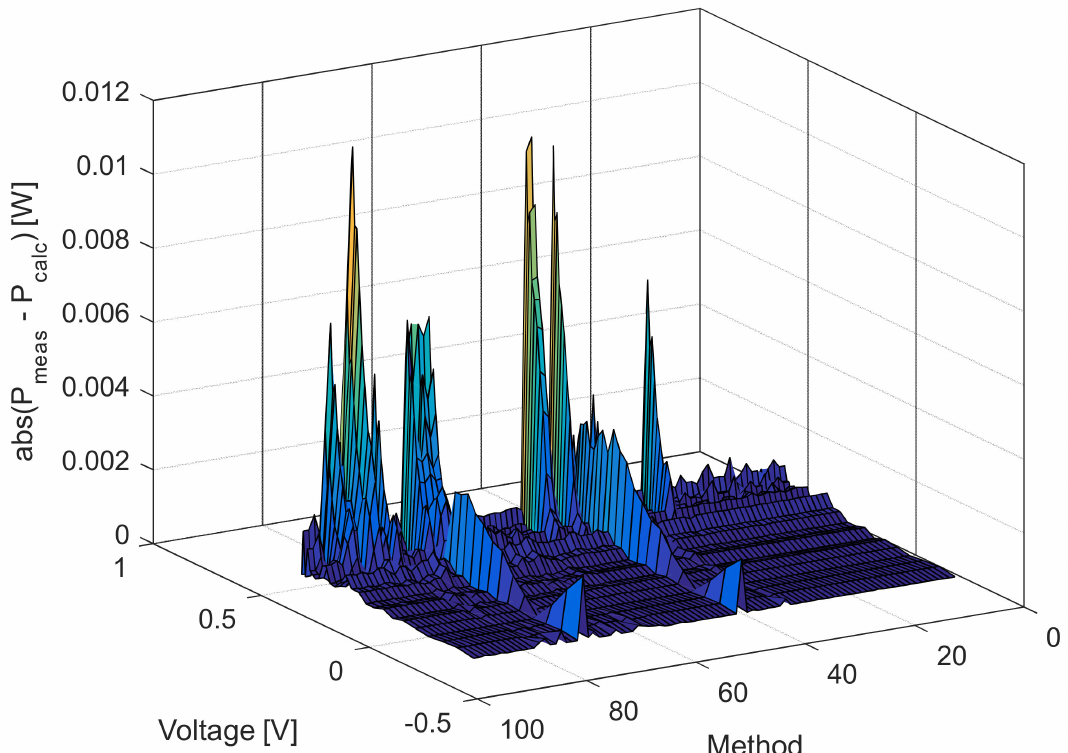
Figure 9. Difference between the measured and calculated power values for the methods listed in Table